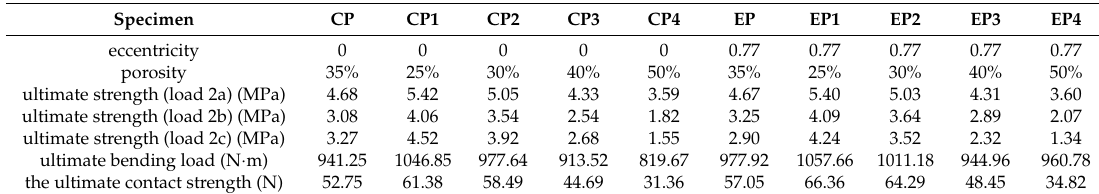
Table 4. Comparison of the ultimate strength under different porosities.